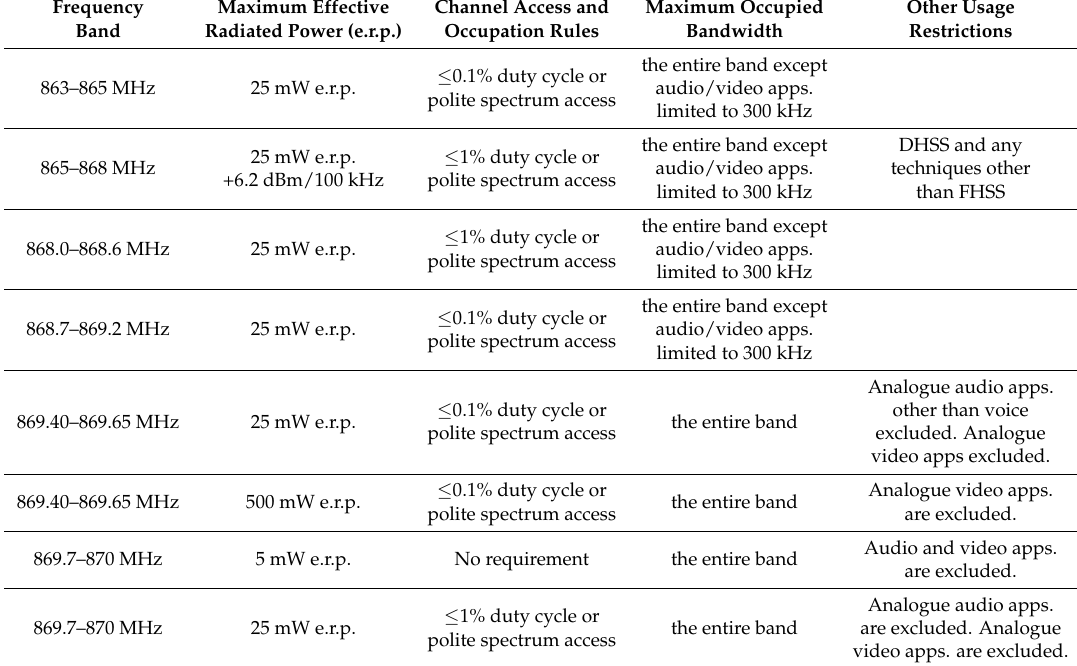
Table 4. EU Harmonized NRI for the 863–870 MHz band. A device following these rules can be used across Europe. This band is divided into sub-bands, each with a specific regulation. Channel access and occupation rules refers to the duty cycle that devices must respect. Each sub-band also defines the maximum bandwidth a channel can have. The other usage restrictions column indicates the applications that can take place and the transmission techniques than can be used. DSSS is short for Direct Sequence Spread Spectrum, FHSS is short Frequency Hopping Spread Spectrum.